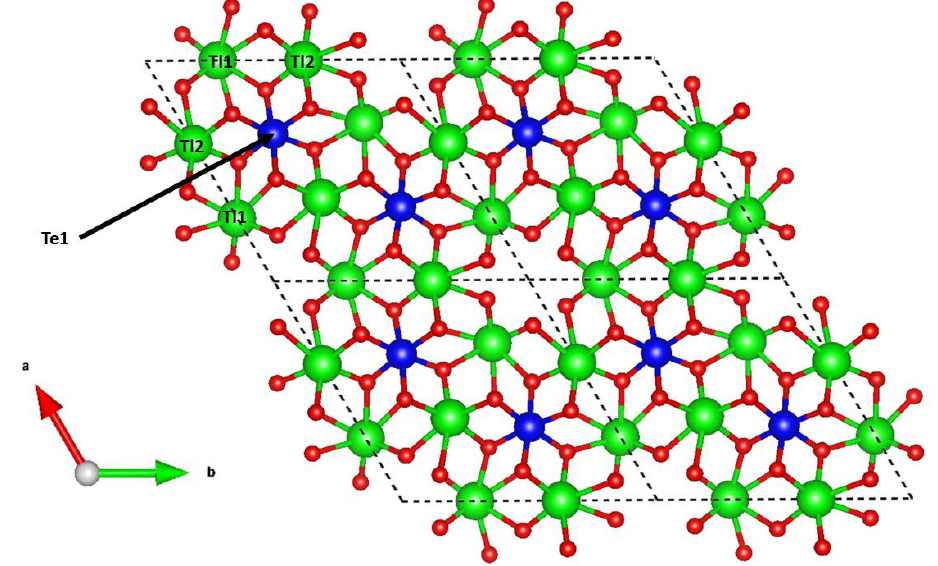
Figure 7. The crystal structure of amgaite along the c axis. In blue, the Te sites are shown, while Tl sites are indicated in green (the red spheres correspond to oxygens). The structure data for drawing are from [20]. Tl1 and Tl2 sites are labeled in the figure, as well as the Te1 site. The Te2 site is not visible over such structure orientation, but it runs along the c axis. The dashed black lines outline the unit